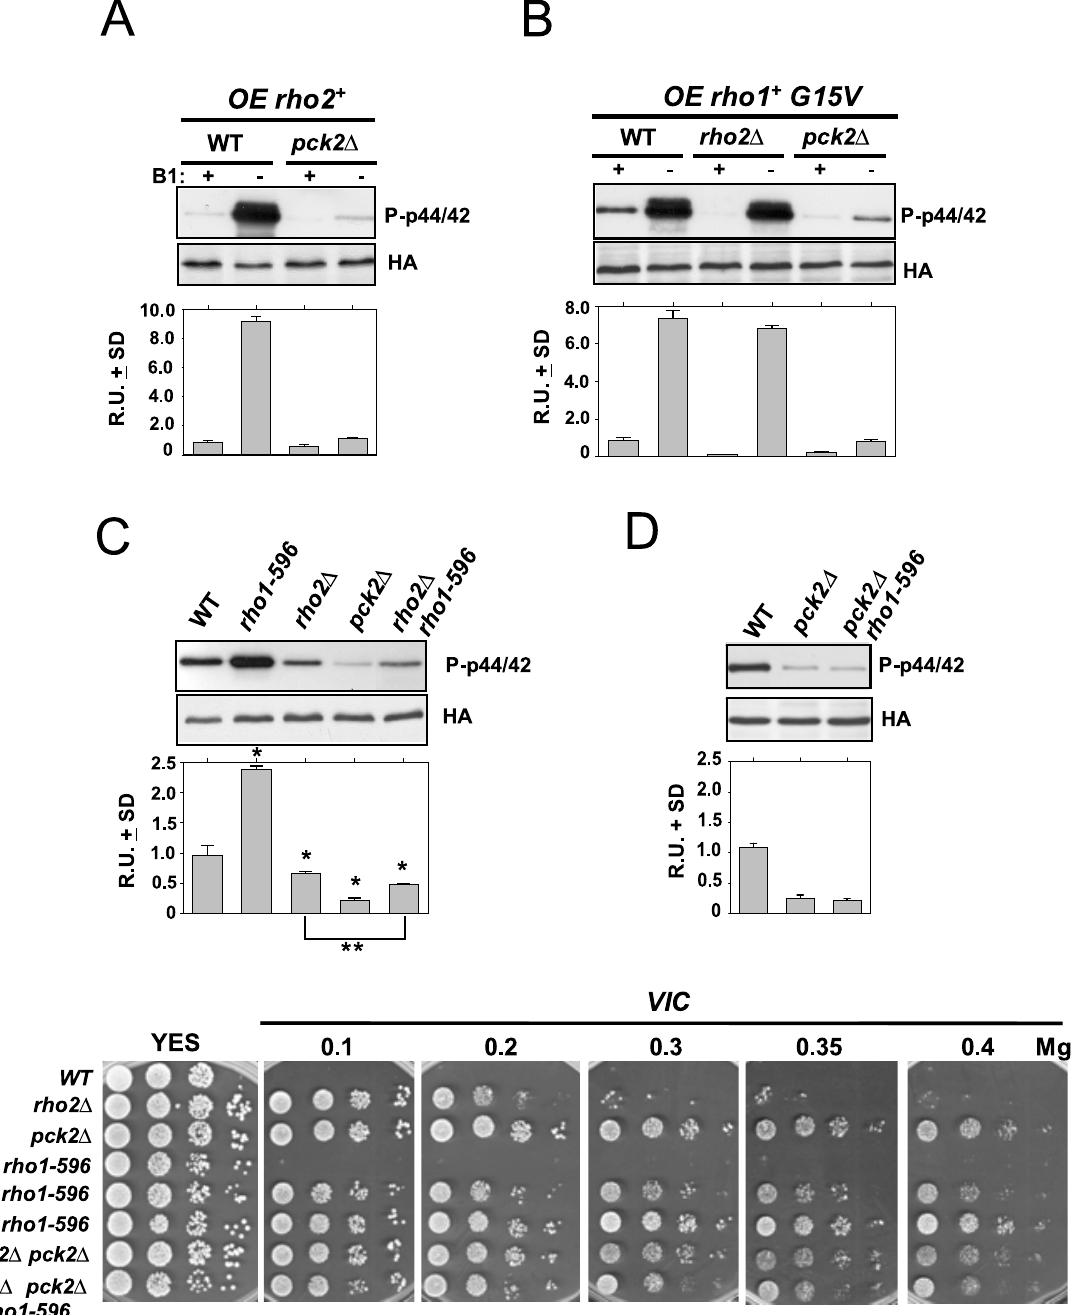
Figure 1. Rho1 GTPase is a positive regulator of the cell integrity MAPK pathway. (A) Strains MI200 (WT) and GB3 ( pck2 D ) were separately transformed with pREP3X- rho2 + plasmid and grown for 18 h in the presence ( + B1) or absence ( 2 B1) of thiamine. Activated Pmk1 was detected by immunoblotting with anti-phospho-p42/44 and total Pmk1 with anti-HA antibodies. (B) Strains MI200 (Control), MI700 ( rho2 D ), and GB3 ( pck2 D ) were separately transformed with pREP3X- rho1 + ( G15V ) plasmid, grown for 18 h with or without thiamine, and both total and activated Pmk1 were detected as above. (C) Strains MI200 (WT), GB3 ( pck2 D ), and LS203 ( rho1-596 pck2 D ) were grown in YES medium to mid log-phase. Aliquots were harvested and Pmk1-HA6H was purified by affinity chromatography. Pmk1-HA6H was purified and the activated and total Pmk1 was detected as already indicated. *, P , 0.05 in mutant strains as compared to the wild type. **, P , 0.04 in rho1-596 rho2 D cells as compared to the rho2 D mutant. (D) Strains MI200 (WT), LS201 ( rho1-596 ), MI700 ( rho2 D ), GB3 ( pck2 ) and LS202 ( rho1-596 rho2 D ) were grown in YES medium to mid log-phase. And both activated and total Pmk1 was detected as above. (E) VIC assays for strains MI200 (WT), MI700 ( rho2 D ), GB3 ( pck2 D ), LS201 ( rho1-596 ), GB29 ( rho2 D pck2 D ), LS202 ( rho1-596 rho2 D ), LS203 ( rho1-596 pck2 D ), and LS207 ( rho1-596 rho2 D pck2 D ). After growth in YES medium, 10 4 , 10 3 or 10 2 cells were spotted onto YES plates supplemented with 0.5 m g/ml FK506 plus 0.1, 0.2, 0.3, 0.35 or 0.4 M MgCl 2 , and incubated for 4 days at 28 u C before being photographed.